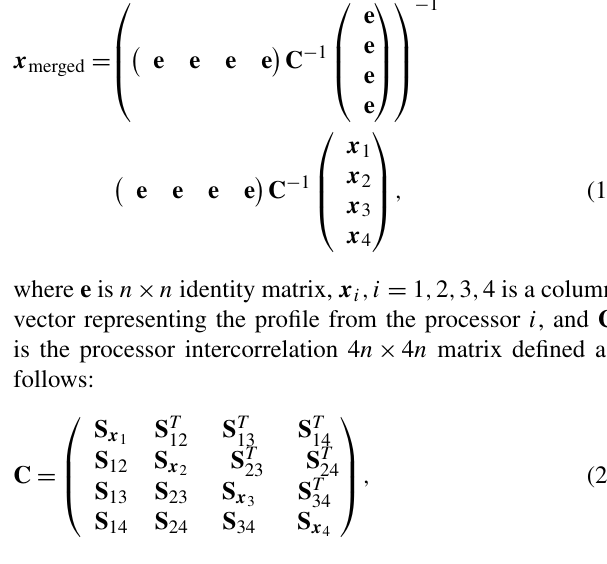
Table 1. Spectral analysis windows used by the four MIPAS pro- cessors for ozone